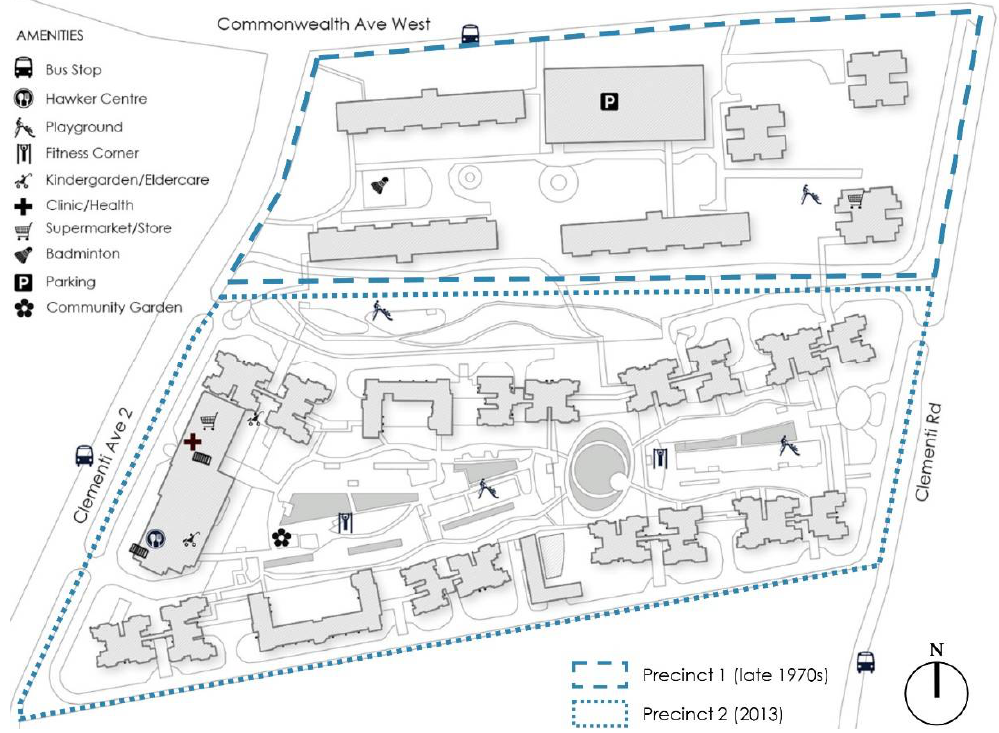
Figure 4. Neighbourhood 2: Clementi—spatial layout and amenities (source: by author).